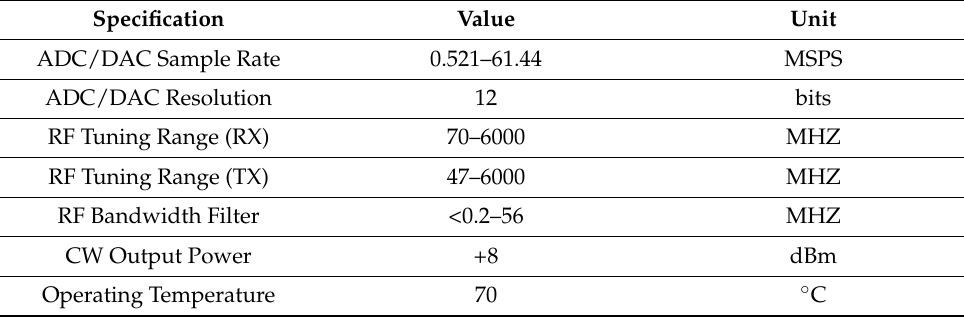
Table 1. BladeRF 2.0 micro xA4